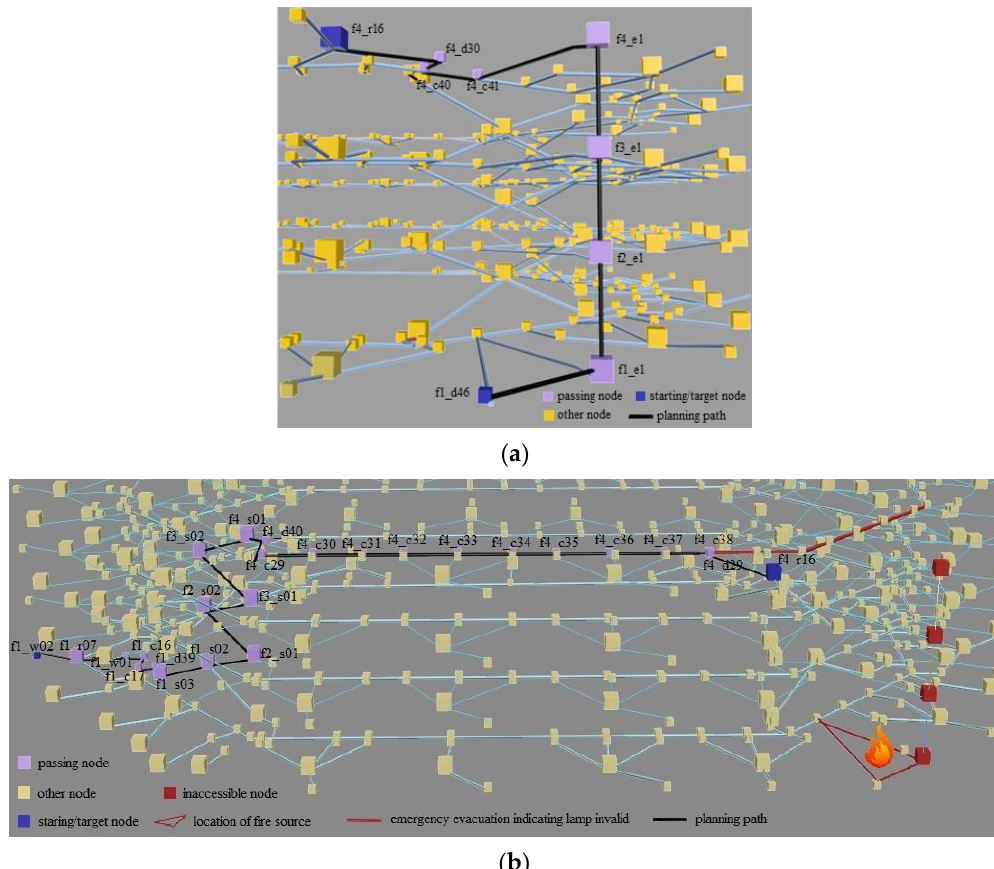
Figure 12. Impact of multi-semantic constraints on indoor 3D pathfinding. ( a ) Planning path in scenario 1; ( b ) Planning path in scenario 2.